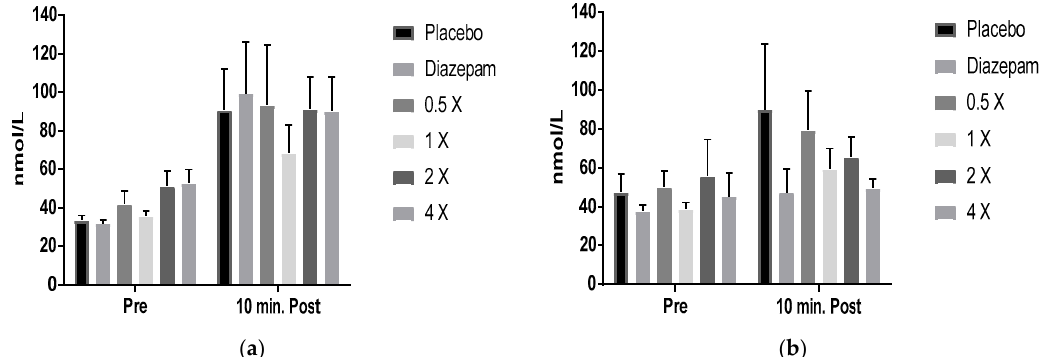
Figure 3. Blood cortisol concentration plotted as a function of drug treatment and temporal relationship to presentation of thunder in animals classified as responders. ( a ) Baseline data prior to drug treatments and ( b ) data during the drug treatment phase. n = 10 animals/group.